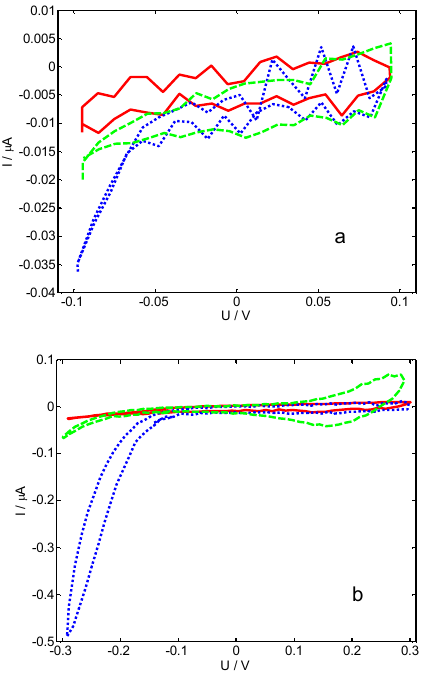
Fig.15: Cyclic voltammogram (CV) for gold electrodes of different area in 140 mM PBS (solid: 1 mm 2 , dotted: 4 mm 2 , dashed: 16 mm 2 ), a) -100 mV < U < 100 mV, b) -300 mV < U < 300 mV. The ramp steepness was set to 10 mV/s. An Ag/AgCl – electrode served as reference while a massive platinum electrode was used as counter